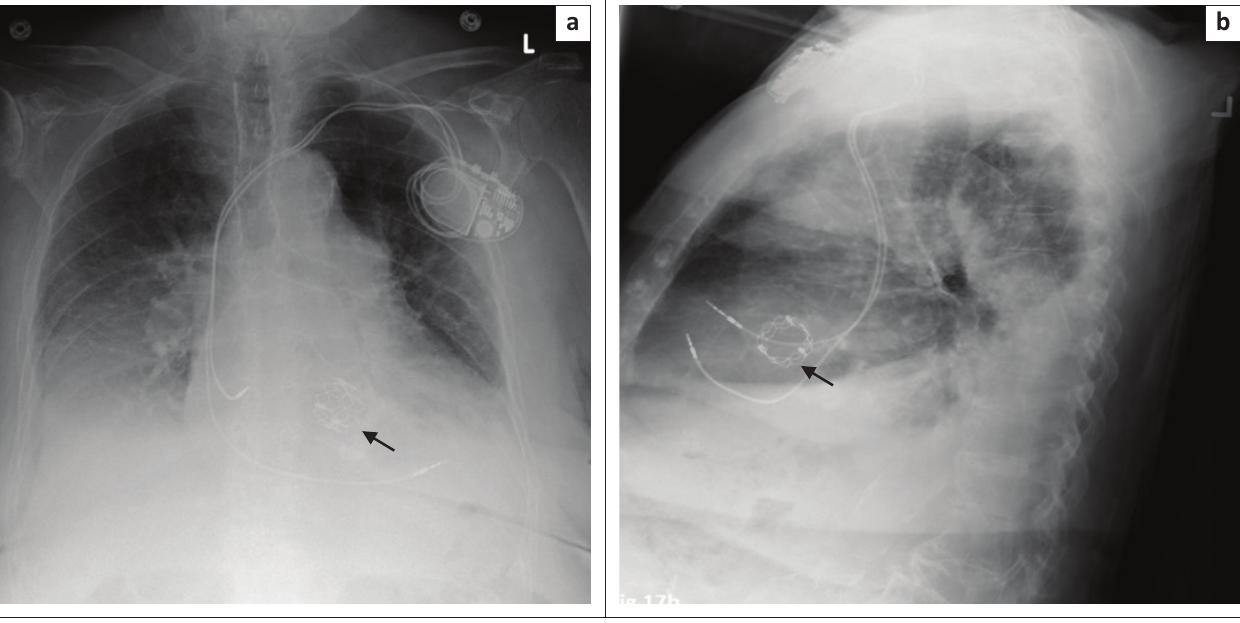
FIGURE 17: Frontal (a) and lateral (b) chest radiographs showing transcatheter aortic valve replacement (arrow) in an 81-year-old female patient with severe aortic